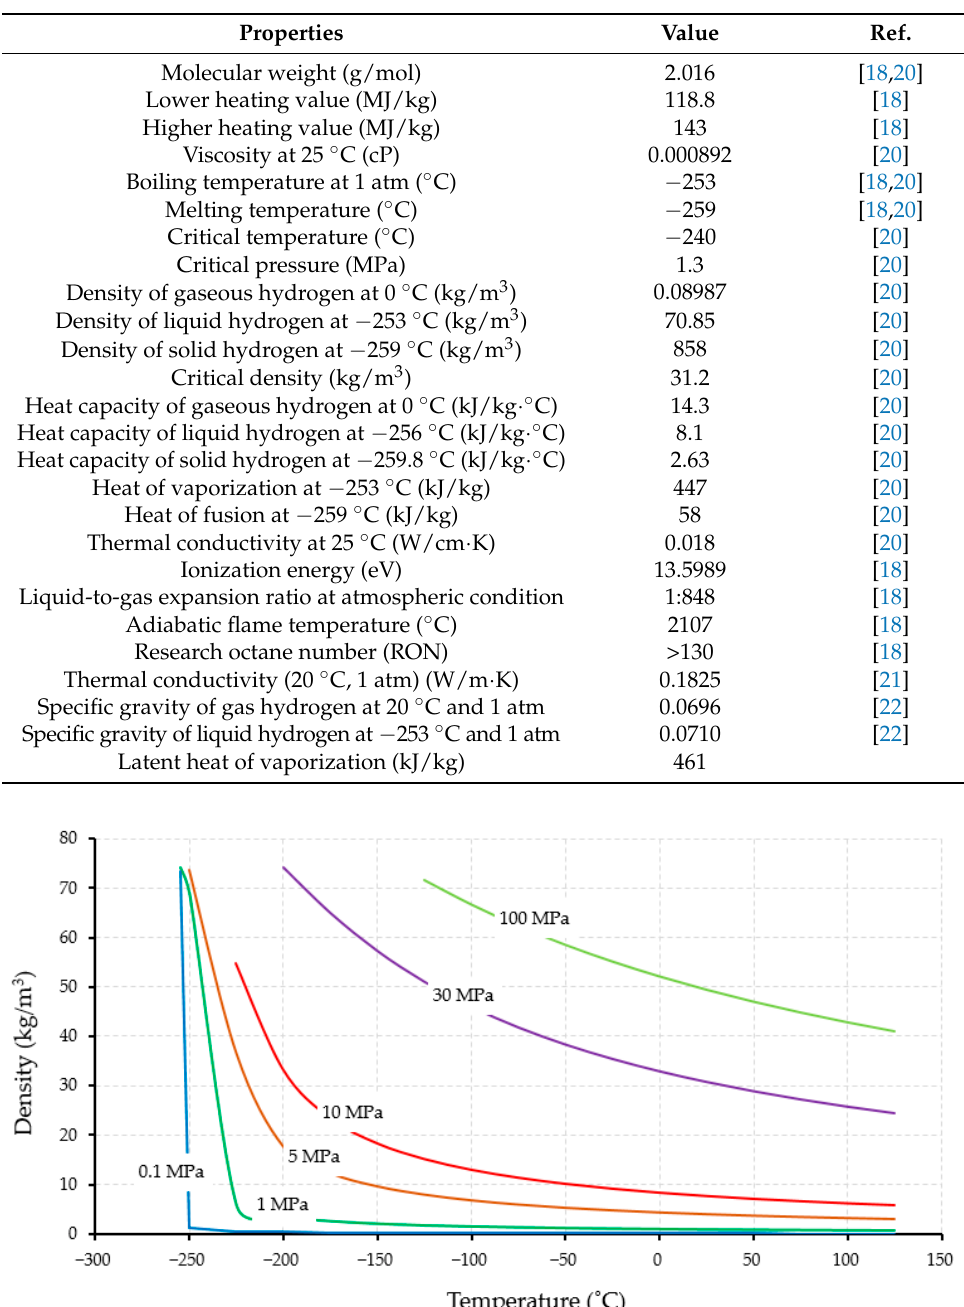
Figure 3. Hydrogen storage options, including physical and chemical storages.